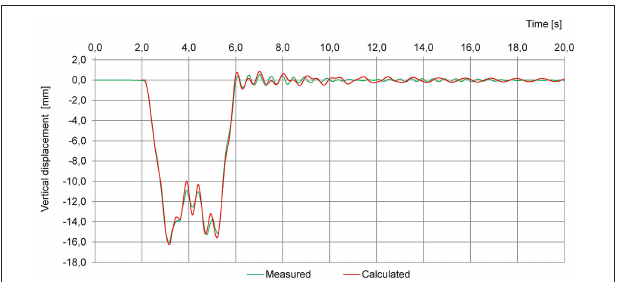
FIGURE 9 | Measured and calculated time histories of vertical displacement for the passage of a special train (two locomotives and four passenger railcars placed between them) at 200km/h.